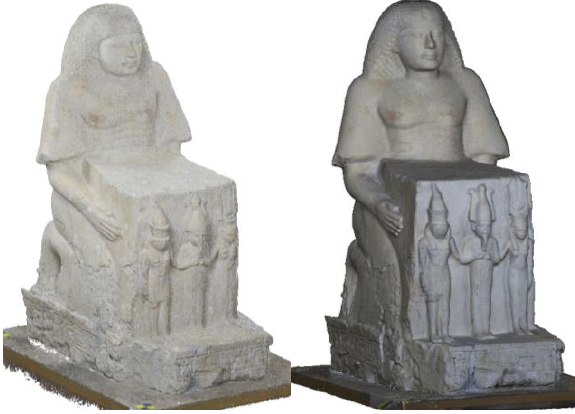
Figure 2. Photogrammetric point cloud and textured